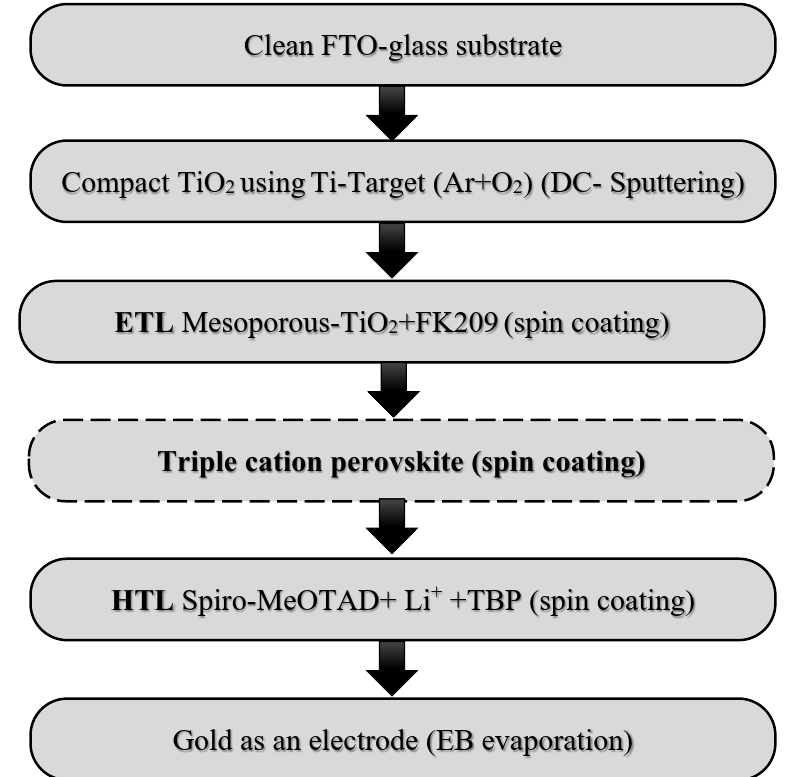
Figure 1. A flowchart of perovskite solar cell manufacturing.